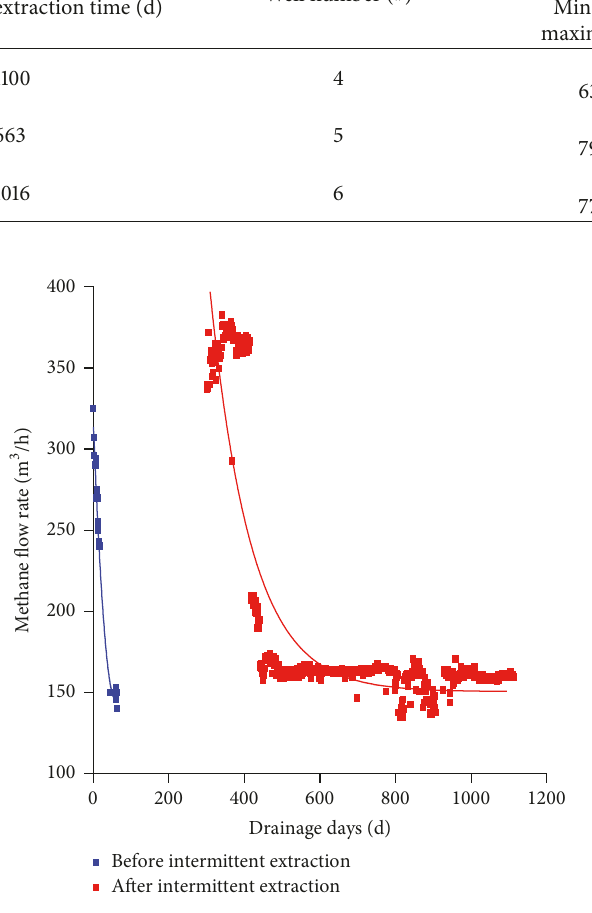
Figure 9: Methane extraction flows before and after intermittent